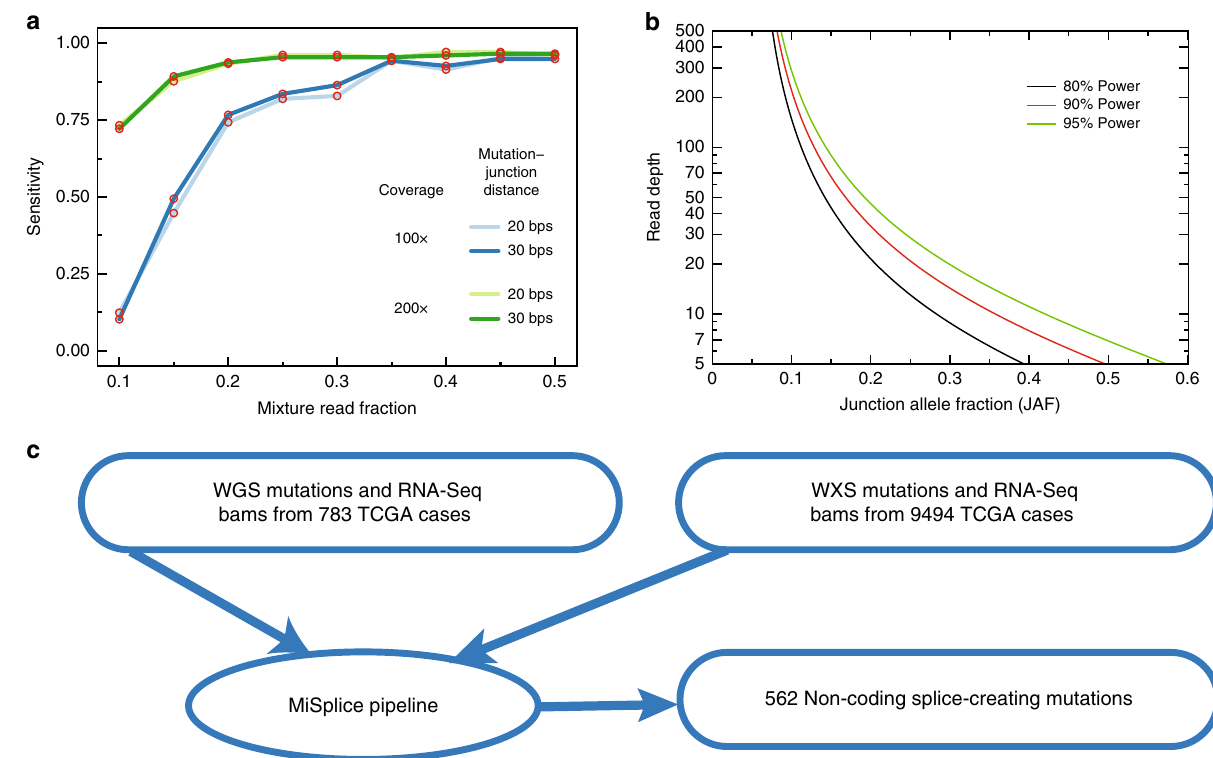
Fig. 1 Benchmark test of MiSplice pipeline and sample set. a Sensitivity curves derived by simulating various coverage levels and mutation distances plotted as a function of splice allele fraction (ratio of non-canonical junction reads over canonical junction reads). b Required junction read coverage to achieve suf fi cient power. c Sample data set processed by MiSplice pipeline. Source data are provided as a Source Data fi